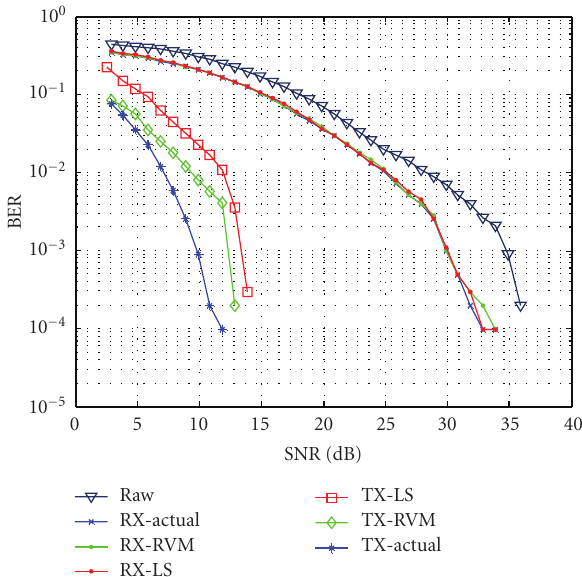
Figure 7: Comparisons of BER curves with FEQ at receiver to that at